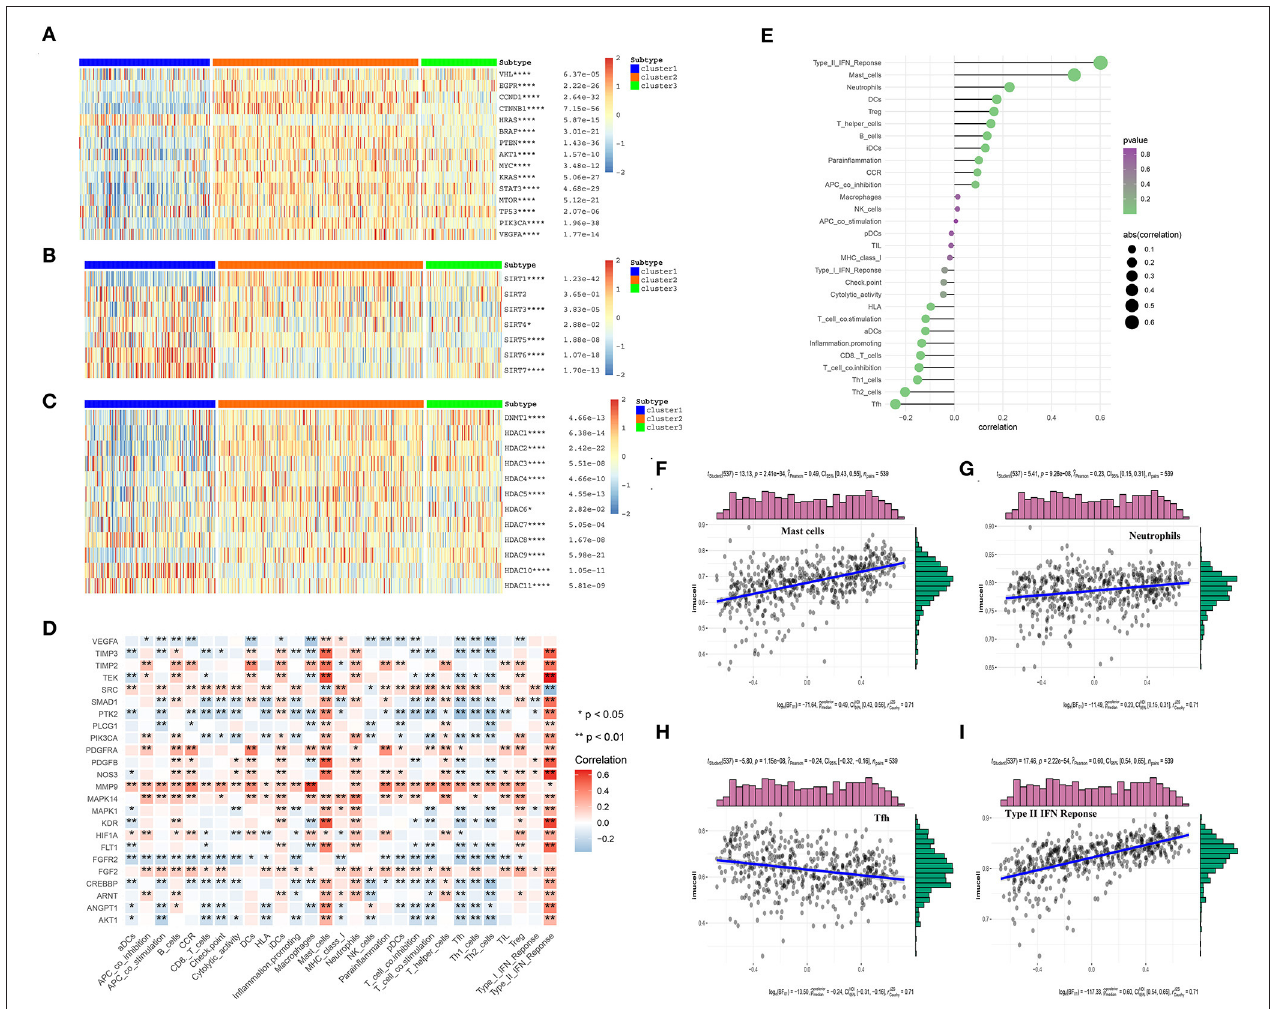
FIGURE 6 | The correlations between the angiogenesis score and the classical cancer-related genes or immune cell infiltration. (A–C) Heatmap shows that the angiogenesis-score is correlated with other signaling pathways in KIRC. (A) The correlation with oncogenes and tumor suppressor genes. (B) The correlation with sirtuin family genes. (C) The correlation with histone deacetylases (HDAC) family genes. The statistical method used in A – C is “ANOVA” (* p < 0.05, ** p < 0.01, *** p < 0.005, and **** p < 0.001). (D) The heat map shows that the correlation between the angiogenesis pathway genes and immune cells infiltration. The “ggplot2” and “dplyr” packages in R Studio were then used to draw the heat map, with Spearman’s correlation coefficient being applied for the statistical analysis. Red represents positive correlation and blue represents negative correlation (* p < 0.05 and ** p < 0.01). (E) The plot shows the correlation between the angiogenesis-score and immune cells infiltration. On the right side of the plot, the area of the sphere represents the degree of abs (correlation) and the color indicates the p -value. (F–I) The scatter diagram shows the correlation between the angiogenesis-score and four immune-infiltration-related substances. The angiogenesis-score was found to be positively correlated with the infiltration of type II IFN response cells, mast cells, and neutrophils, and negatively correlated with that of Tfh